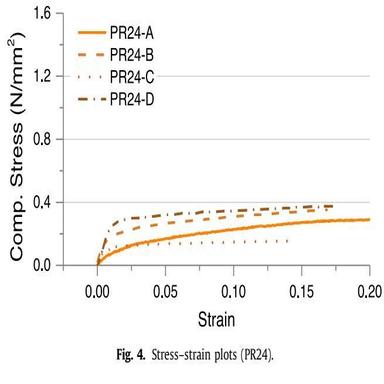
Stress–strain plots (PR32).